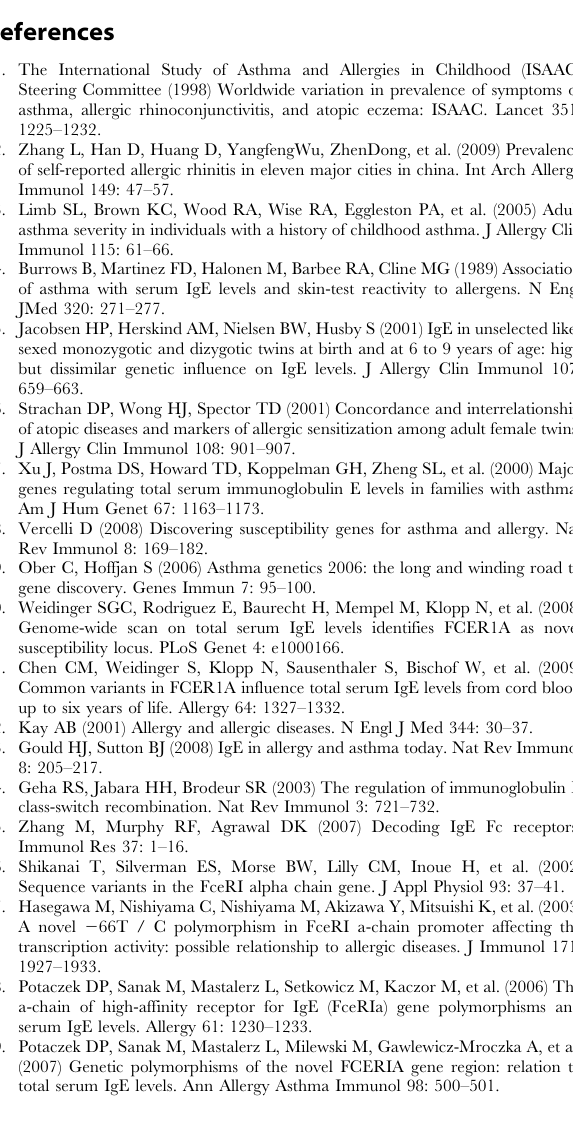
Table S2 Details of the primers used in the screening of SNPs by MassArray and PCR direct sequencing